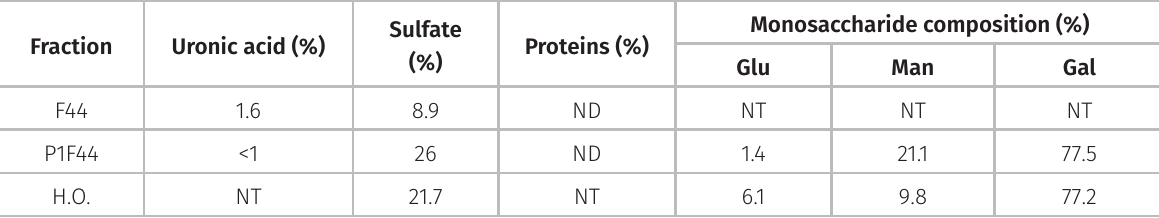
Figure 6 . Infrared spectrum of the P1F44 fraction extracted from H.